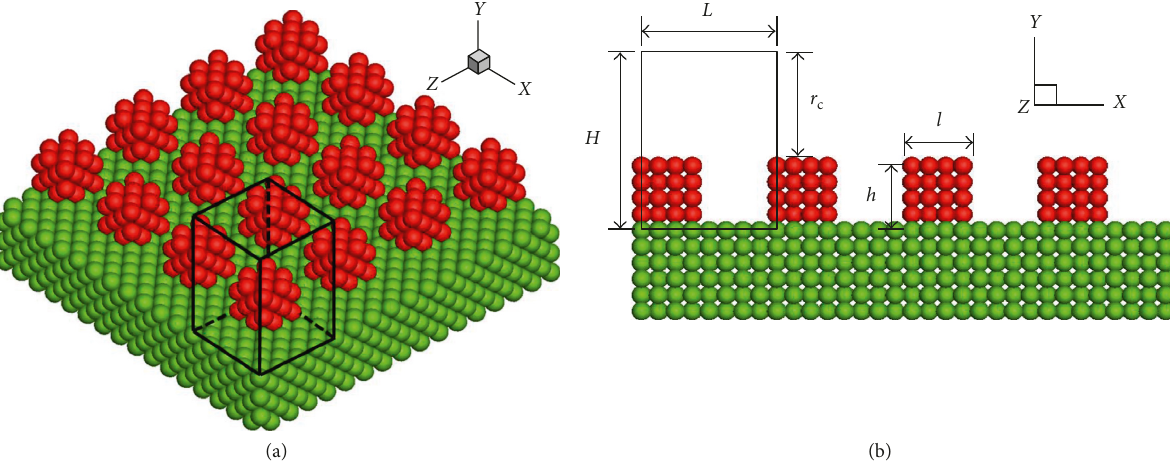
Figure 2: Schematics of the rough wall and the unit cuboid domain: (a) axonometric view; (b) side